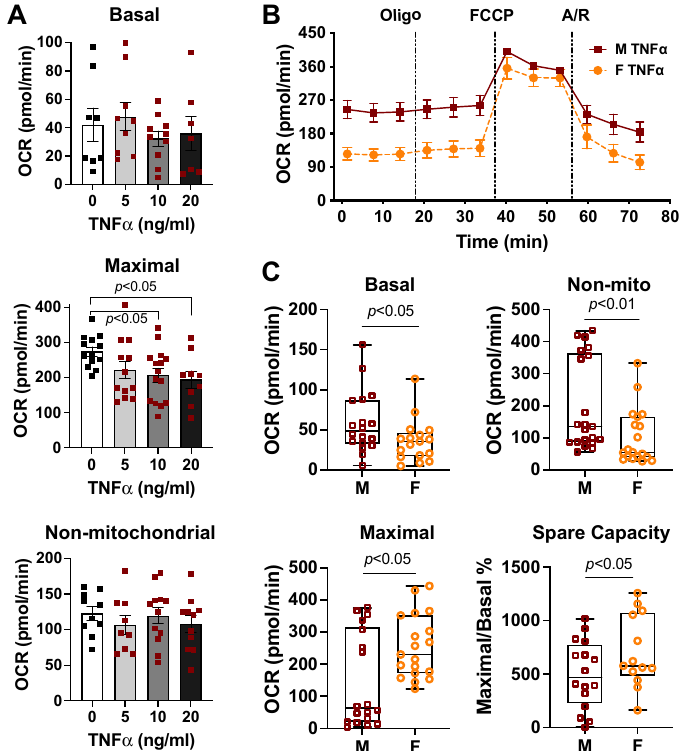
Figure 3. Sex differences in TNF α -changed metabolic profiling between cardiomyocytes isolated from adult male and female mice. ( A ) TNF α dose-responsive mitochondrial function: basal, non- mitochondrial, and maximal OCR in cardiomyocytes from male mice. Data were analyzed using one-way ANOVA with Dunnett’s multiple comparisons test and represented as the mean ± SEM. ( B ) The OCR trace in cardiomyocytes isolated from male (M) and female (F) mice following TNF α treatment (10 ng/mL, 1 h). ( C ) Quantification of basal OCR, non-mitochondrial OCR, maximal rate, and spare respiratory capacity in cardiomyocytes isolated from M and F mice subjected to TNF α (10 ng/mL, 1h). Data were evaluated using the Mann–Whitney test in C except for spare capacity ( t -test) and shown as box and whiskers plots. The results from four mouse hearts of each sex in three